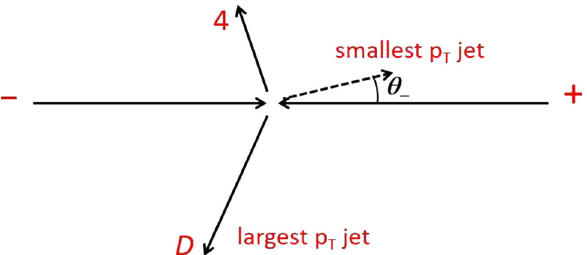
Fig. 1 A configuration of three jet production in which the jet with the smallest transverse momentum p T aligns more closely with the incom- ing proton in the ‘ − ’ direction. For this part of the cross section, σ − , the NLO emissions can be resummed and transferred to the LO PDF (μ − ) with optimal scale μ − . Similarly, those parts of the cross section where the smallest p T jet is aligned more closely with the incoming proton ‘ + ’ direction or with the largest p T jet D can be used to determine the optimal scales μ + and μ D